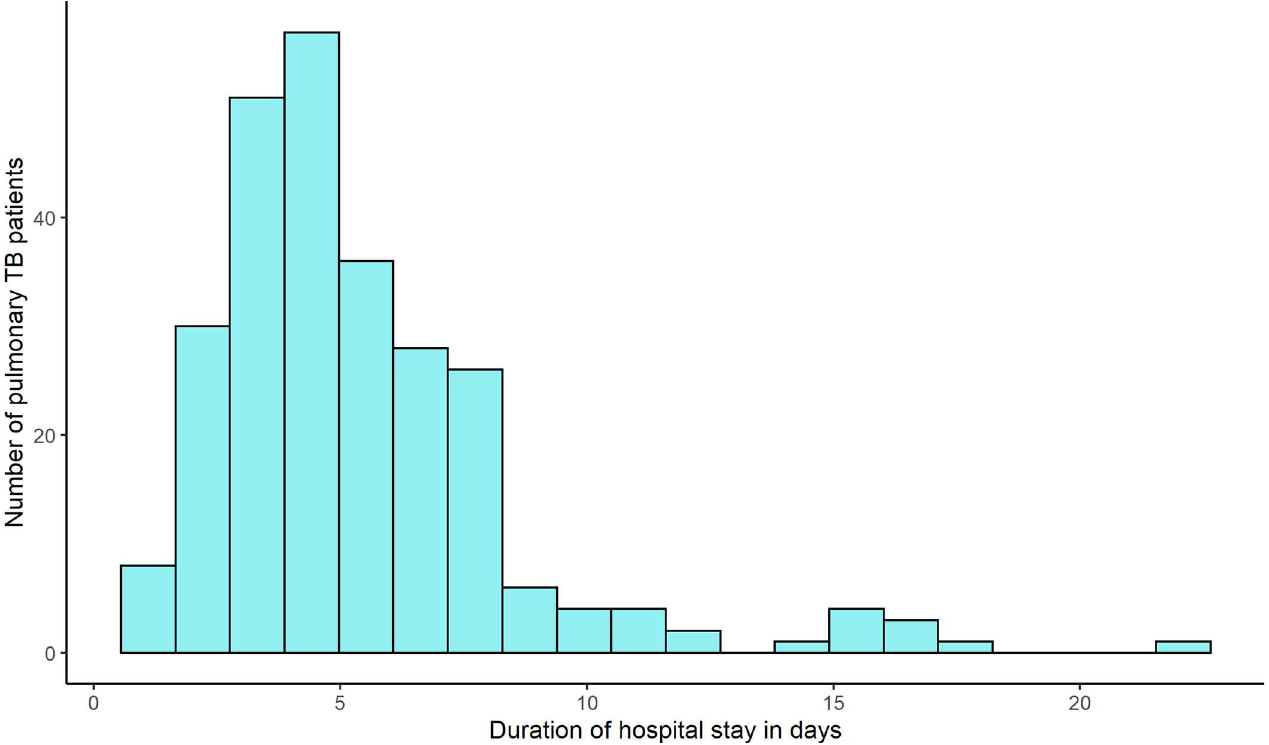
Fig 3. Duration of pulmonary TB patient’s hospital stay in two public tertiary care hospitals,